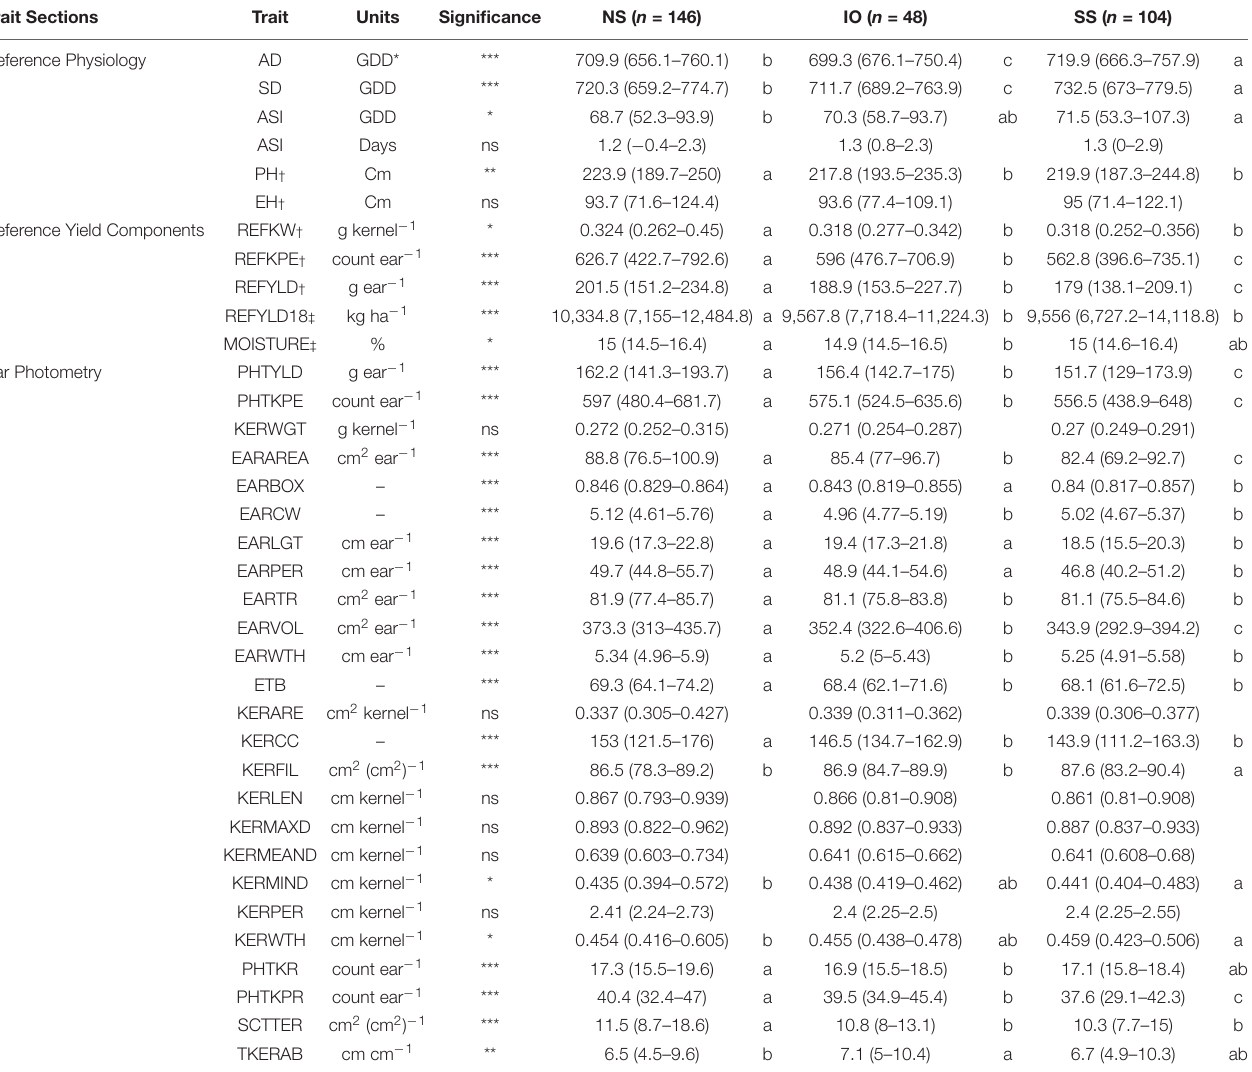
TABLE 2 | Best linear unbiased predictions (BLUPs) of all traits measured in this study for inbred lines crossed to 2FACC based on heterotic group, NS (Non-Stiff Stalk), SS (Stiff Stalk), and IO (Iodent). Trait